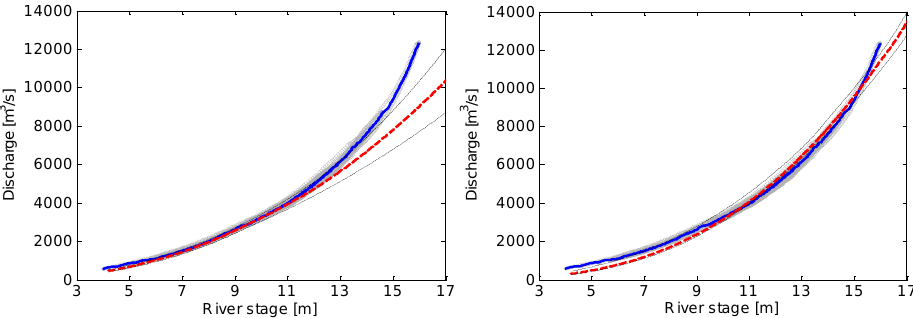
Fig. 3. Rating curves estimated at the Cremona cross-section: normal rating curve (blue line), median rating curve (red dashed line), and corresponding 90% confidence intervals (black lines) for Traditional (left panel) and Constrained (right panel) approaches (Domeneghetti et al.,